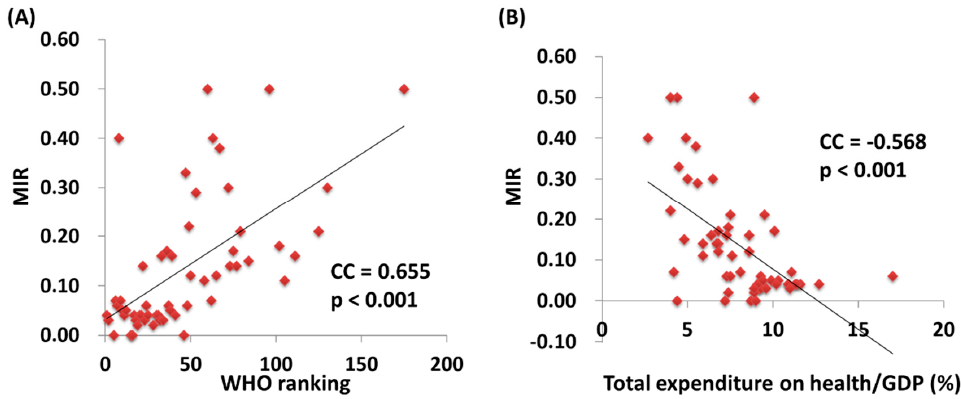
Figure 3. The World Health Organization’s ( A ) rankings and ( B ) total expenditures on health/GDP are significantly associated with the MIR in testicular cancer.